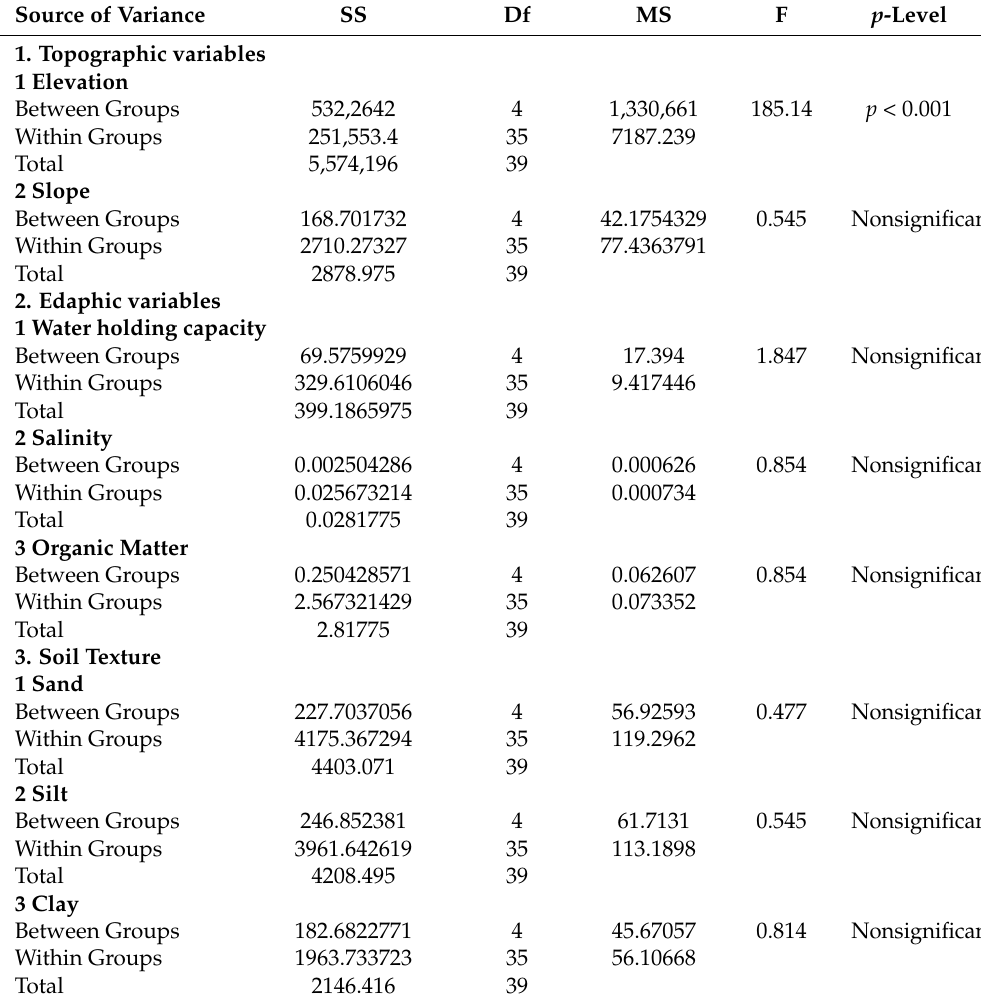
Table 7. Analysis of variance of individual environmental variables (topographic, edaphic, and soil texture) derived by Ward’s cluster analysis using understory vegetation